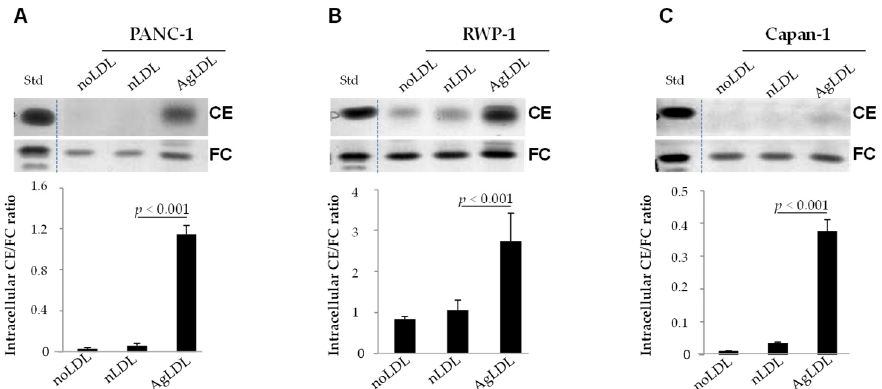
Figure 2. Effects of nLDLs and AgLDLs on the intracellular CE/FC ratio in PANC-1, RWP-1 and Capan-1 pancreatic tumor cells. Cells were untreated or treated with nLDL or AgLDL for 2 h. Representative thin layer chromatography (TLC) images show cholesteryl ester (CE) and free cholesterol (FC) bands; the bar graphs show the intracellular CE/FC ratio in PANC-1 ( A ), RWP-1 ( B ) and Capan-1 ( C ) cell types. Data are shown as the mean ± SEM of three experiments performed in triplicate. Statistical significance was determined by Student’s t -test. CE, cholesteryl ester; FC, free cholesterol; LDL, low-density lipoprotein; nLDLs, native LDLs; AgLDLs, aggregated LDL. Uncropped blots can be found in Figure S6.